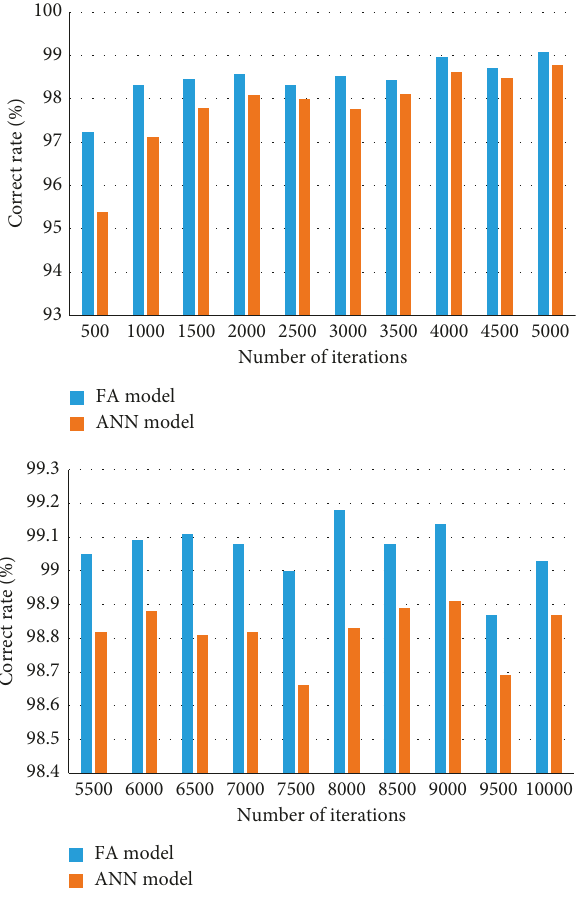
Figure 8: Training set test